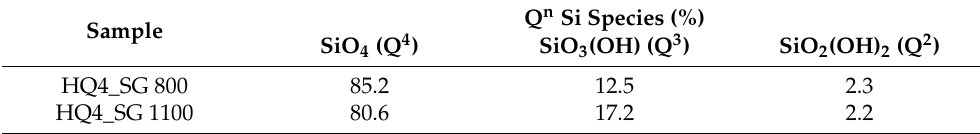
Table 3. Percentage of each Q n Si species calculated from 29 Si MAS NMR.